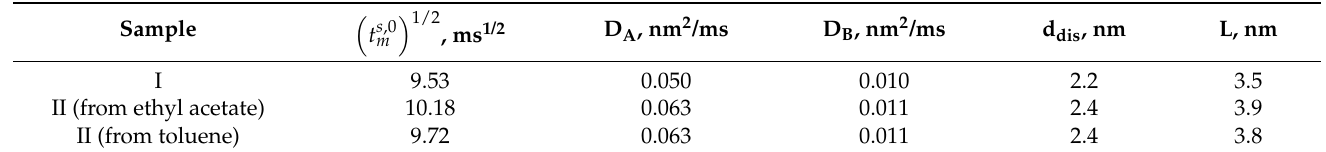
Figure 2. Spin-diffusion curves plotted as the normalized intensity I/I 0 against the square root of the mixing time t m for BCP II films casted from ethyl acetate ( a ) and toluene ( b ). The values of domain diameters and long periods are presented in Table 1 for BCPs I and II samples. Table 1. Domain diameter and long periods of BCPs I and II samples and data used for their calcu- lation ( 𝜌 (cid:3002)(cid:3009) = 0.03 g/cm 3 , 𝜌 (cid:3003)(cid:3009) = 0.9 g/cm 3 ).